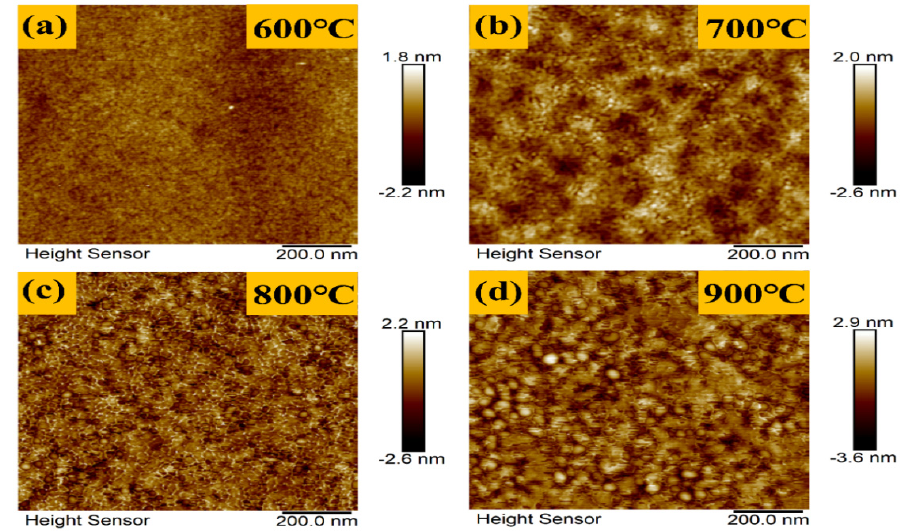
Figure 9. AFM images of AZO films at different annealing temperatures. ( a-d ) at 600, 700, 800, 900 °C annealing respectively. annealing